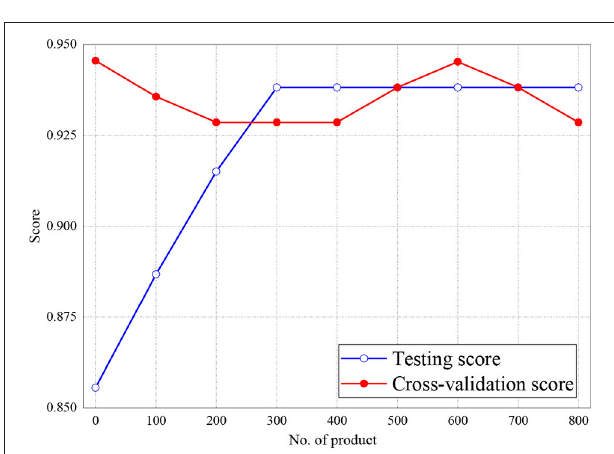
FIGURE 6 | Result for Testing and Cross-Validation of Naive Bayes classifier.